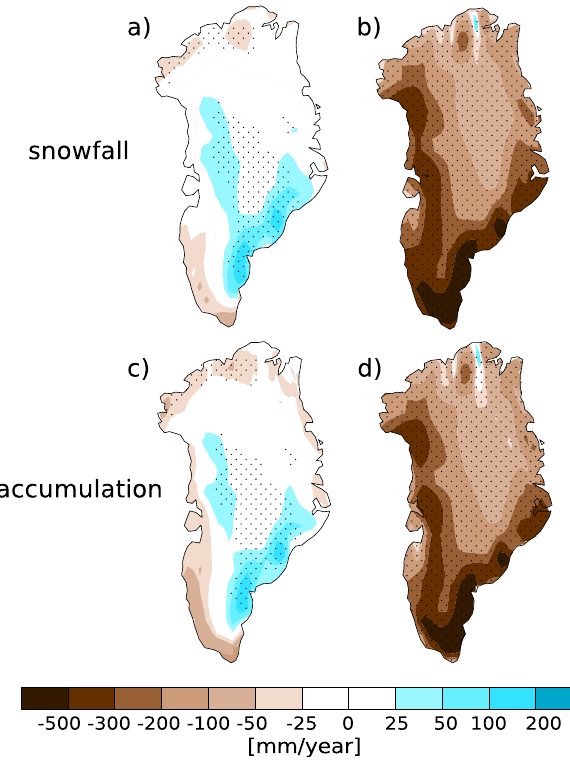
Fig. 4. Annual mean (a, b) snowfall and (c, d) accumulation [mmyr − 1 ] anomalies for EH PD -PI and LGM-PI. Stippling denotes values significant at the 5% level based on t -test